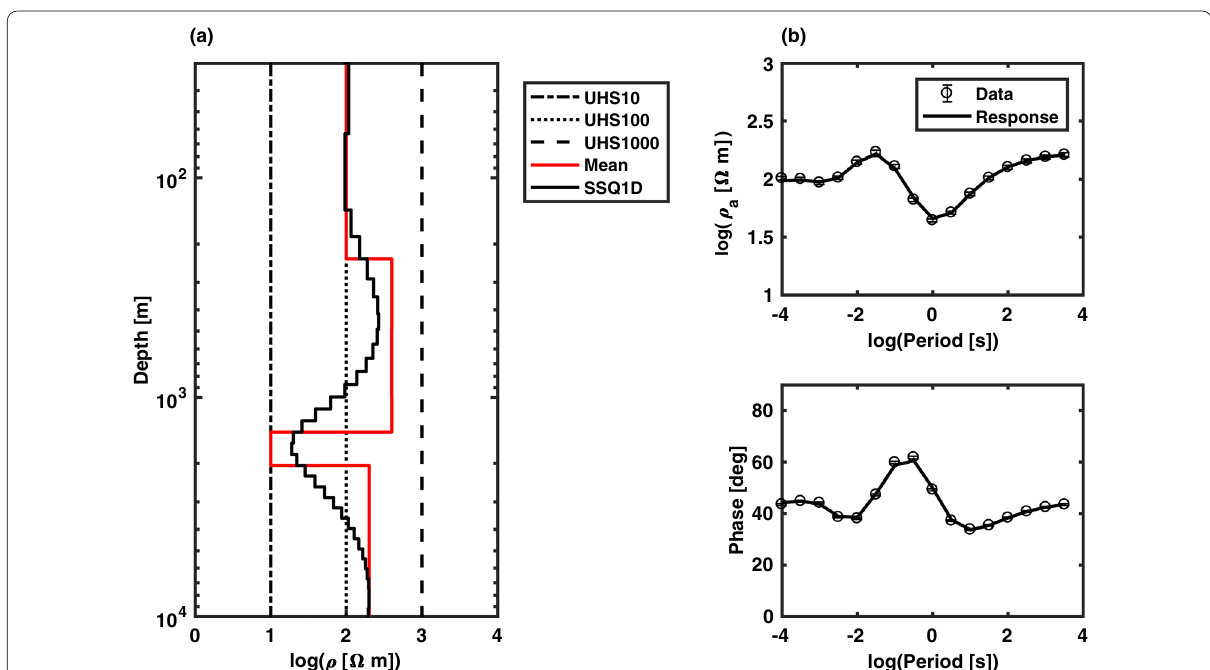
Fig. 7 a Regional mean 1D resistivity profile estimated from the average ssq impedance (SSQ1D, solid black line). The SSQ1D model is compared with the optimal mean 1D profile obtained by an areal average of the synthetic 3D model (red solid line), UHS10 (dashed‑dotted line), UHS 100 (dotted line), and UHS1000 (dashed line). b Synthetic data and inversion responses corresponding to those for the SSQ1D